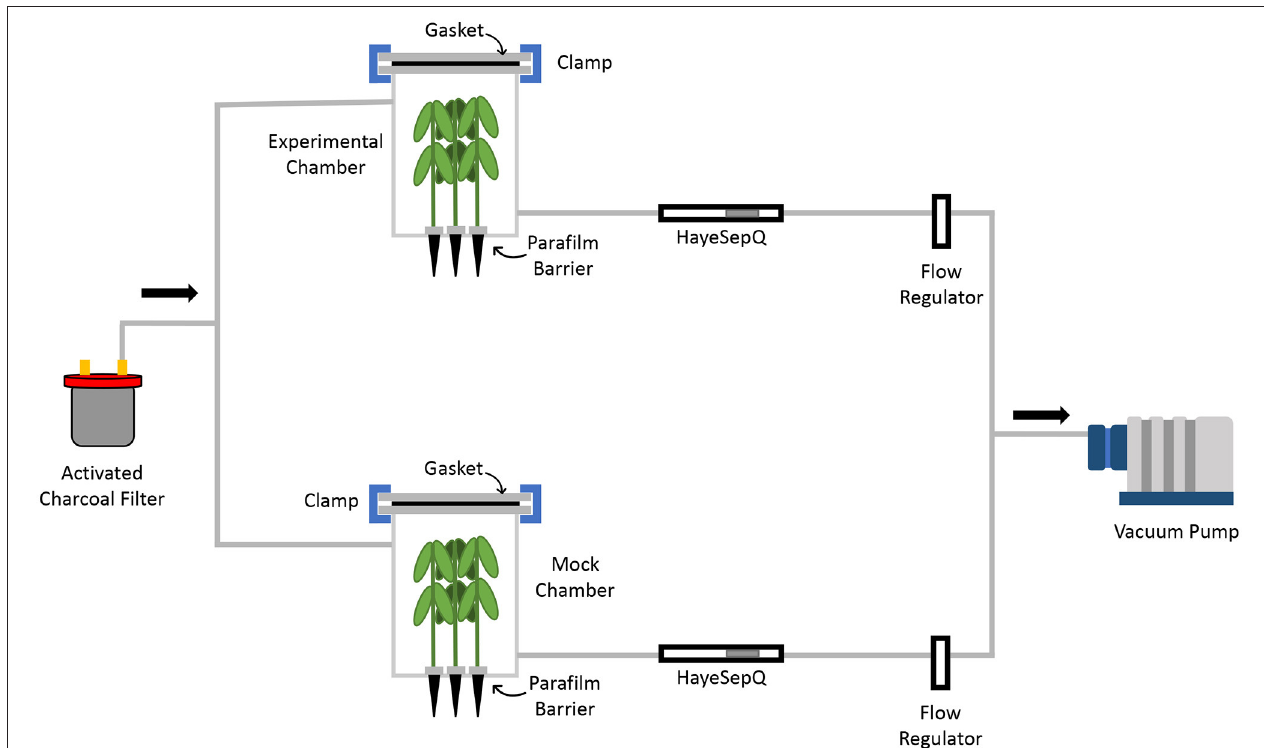
FIGURE 1 | Schematic diagram of volatile collection system for GC-MS analysis. Air entering the chamber was scrubbed using activated charcoal. Volatiles were pulled from the chambers via a vacuum pump and collected by HayeSepQ resin for GC-MS analysis. To ensure only foliar volatiles were collected a parafilm barrier was placed at the base of each soybean